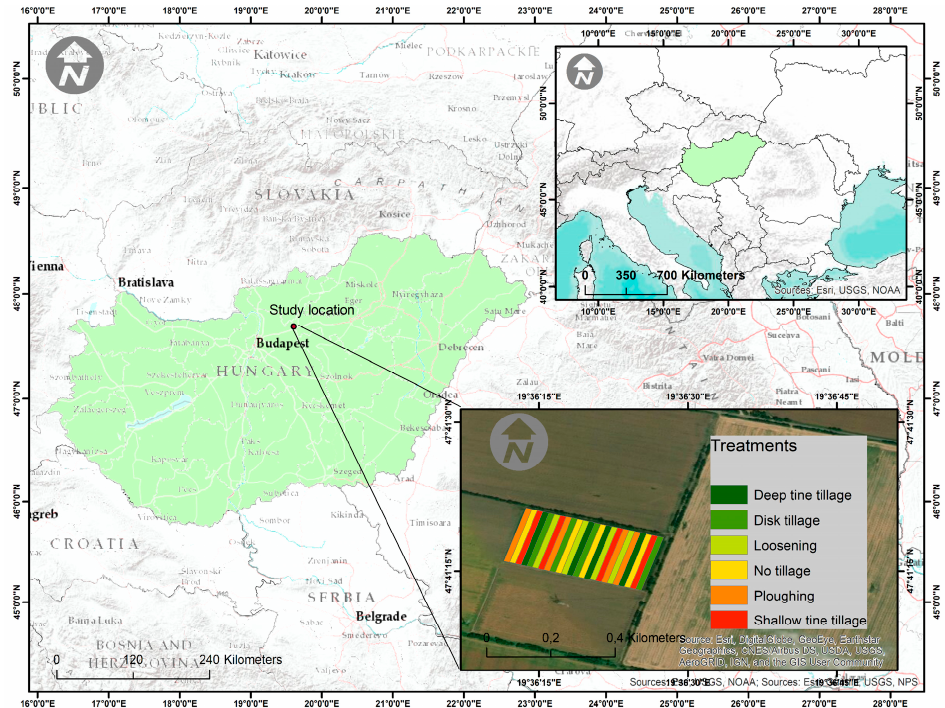
Figure 1. Location of the Józsefmajor Training and Experimental Farm (Source: Dekemati et al., 2020) [44].